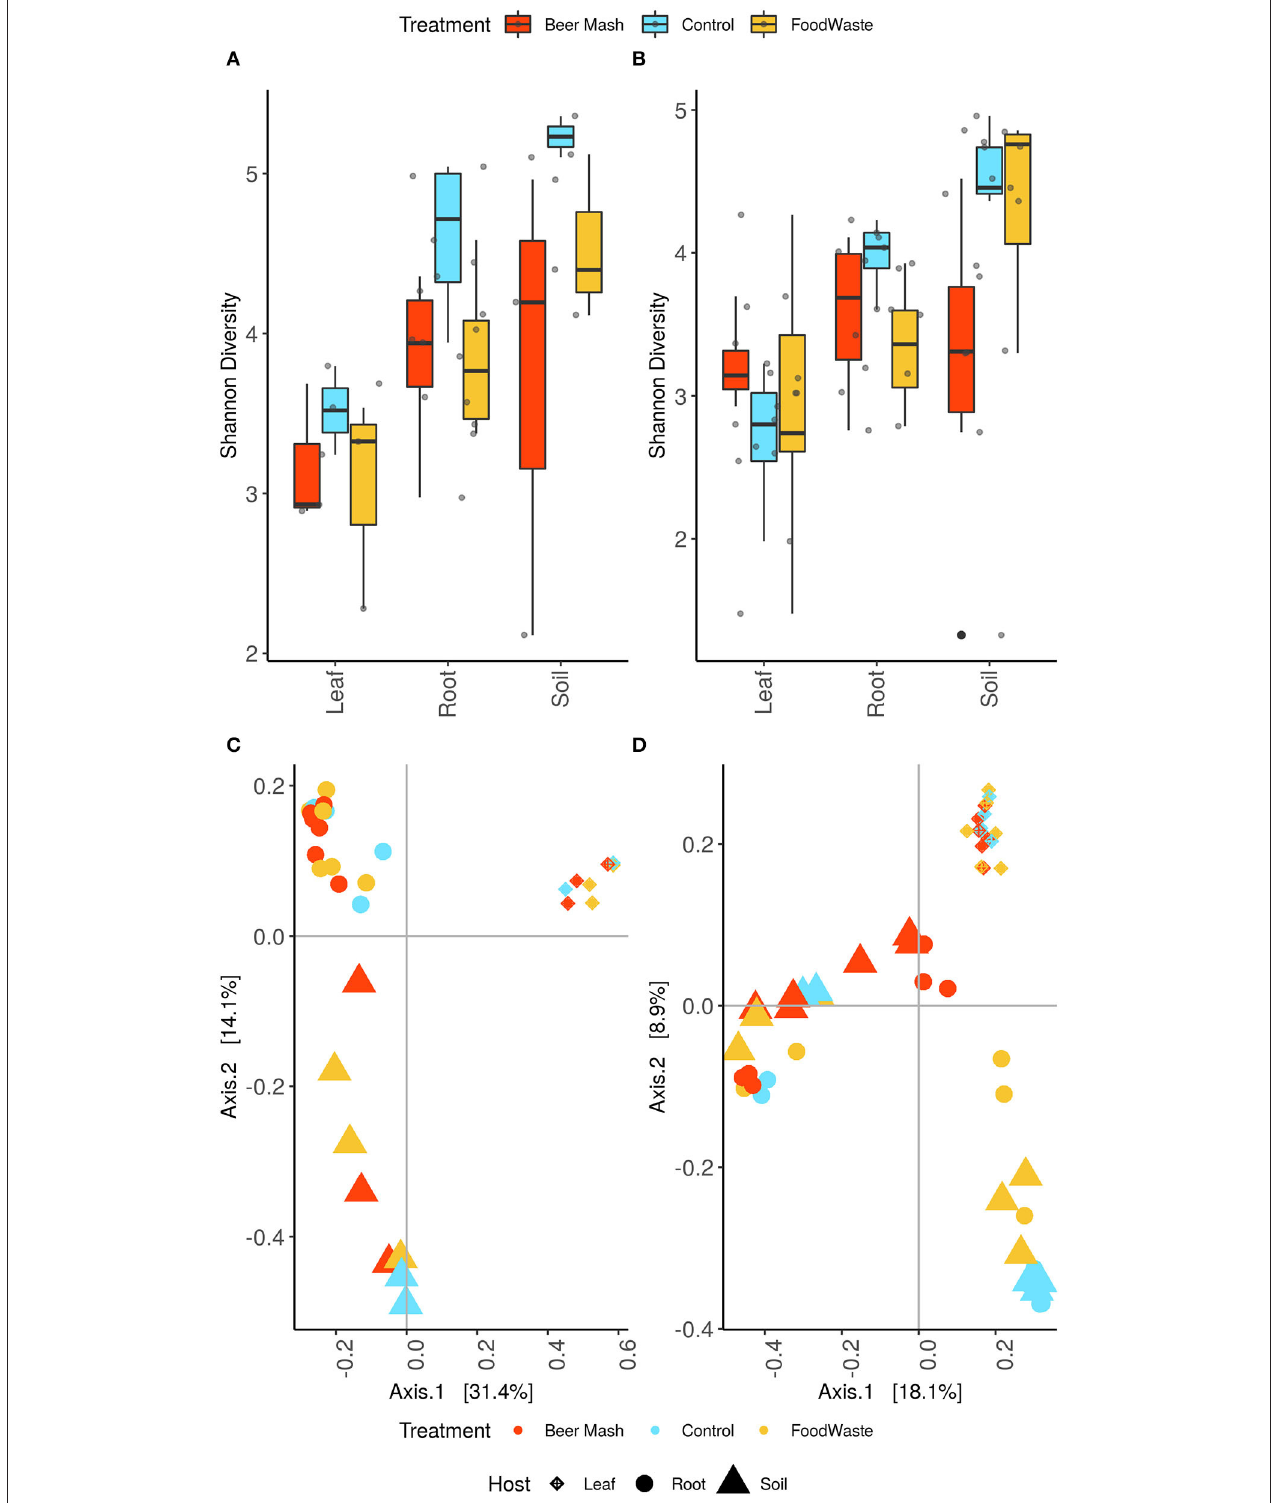
FIGURE 5 | Alpha diversity estimates of the bacterial communities in leaves, root and potting soil samples, for experiment 1 (A) and 2 (B) , were estimated using the Shannon diversity index. Box plots display the first (25%) and third (75%) quartiles, the median and the maximum and minimum observed values within each data set. Alpha diversity estimates represent biological replicates for the soil ( N = 8; 17) root ( N = 16; 17) and leaf samples ( N = 8; 17). Data were analyzed by means of